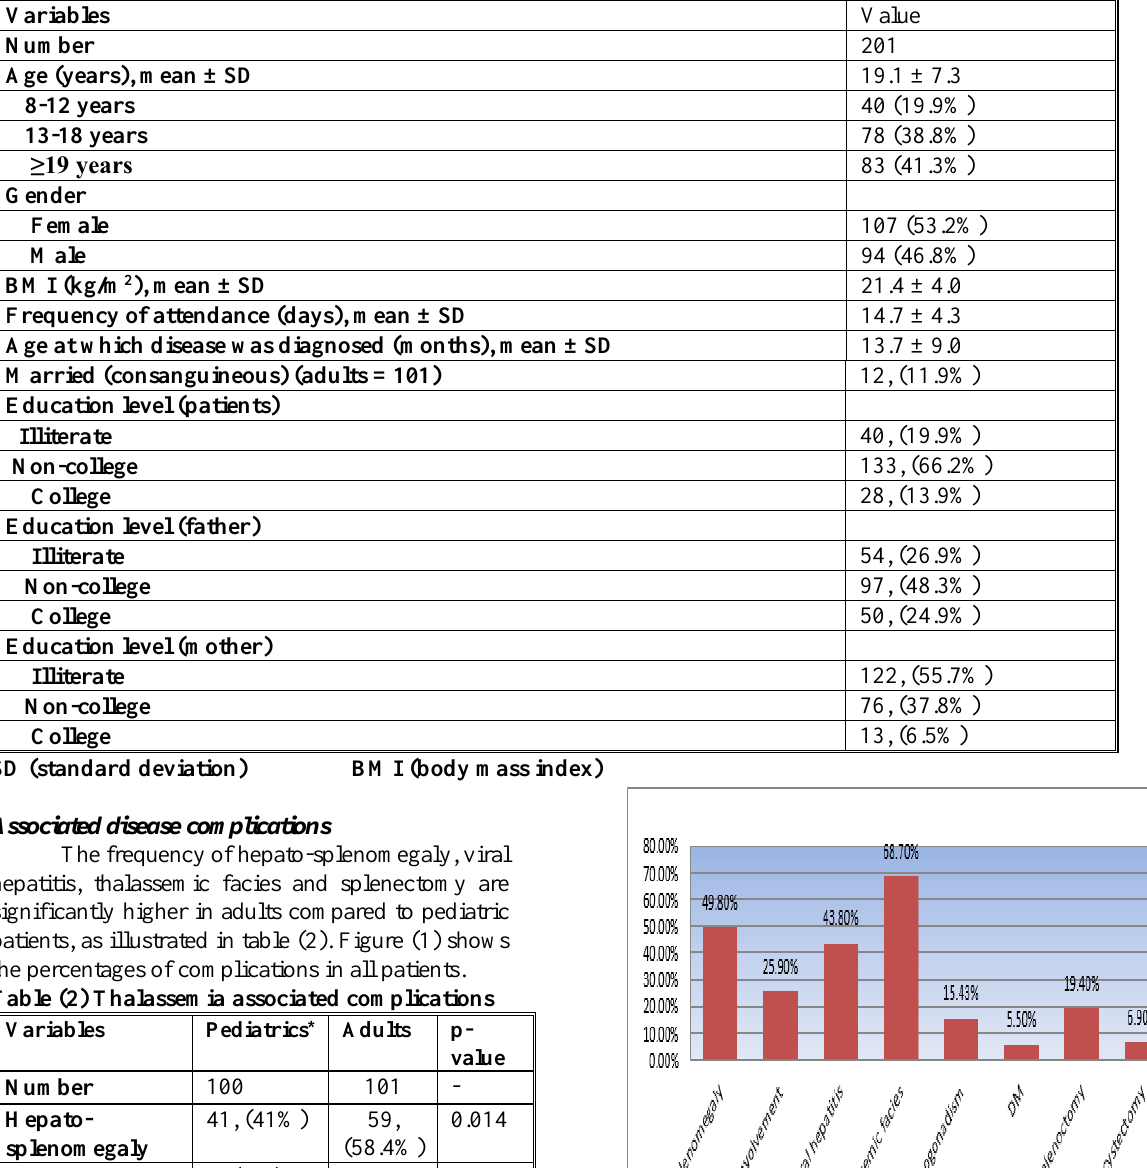
Table (1) Demographic data and disease characteristics Variables